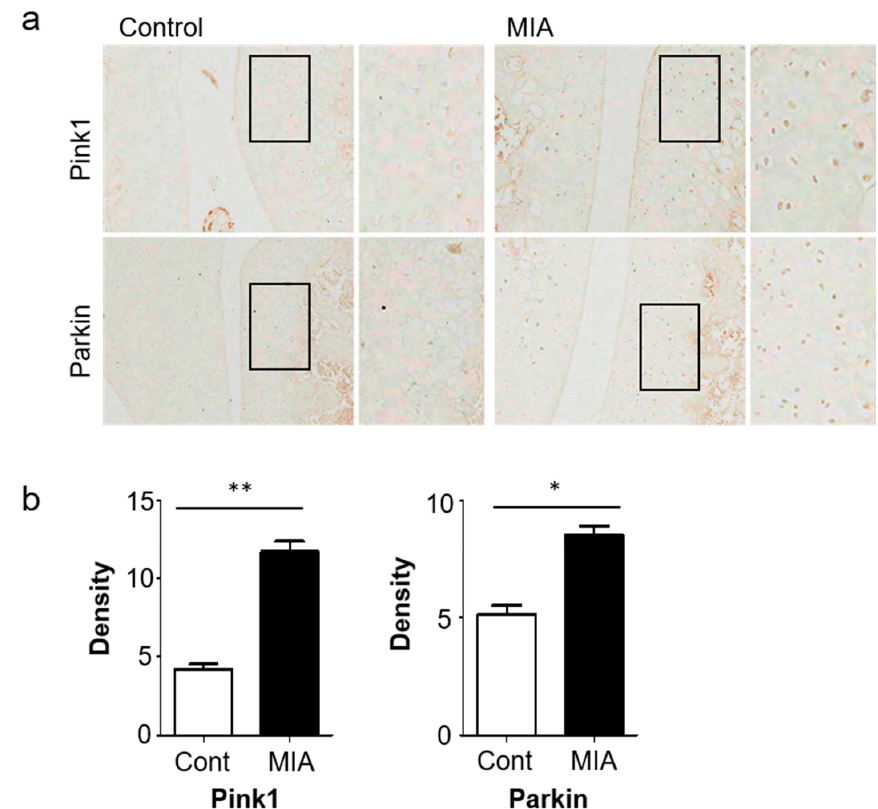
Figure 2. The histopathology of knee joint sections of OA rats demonstrated high levels of mitophagy-related genes. ( a ) Expression levels of Pink1 and Parkin in knee cartilage of OA animal models after 3 days. ( b ) Image J analysis of staining intensity. Scale bar = 50 µm.